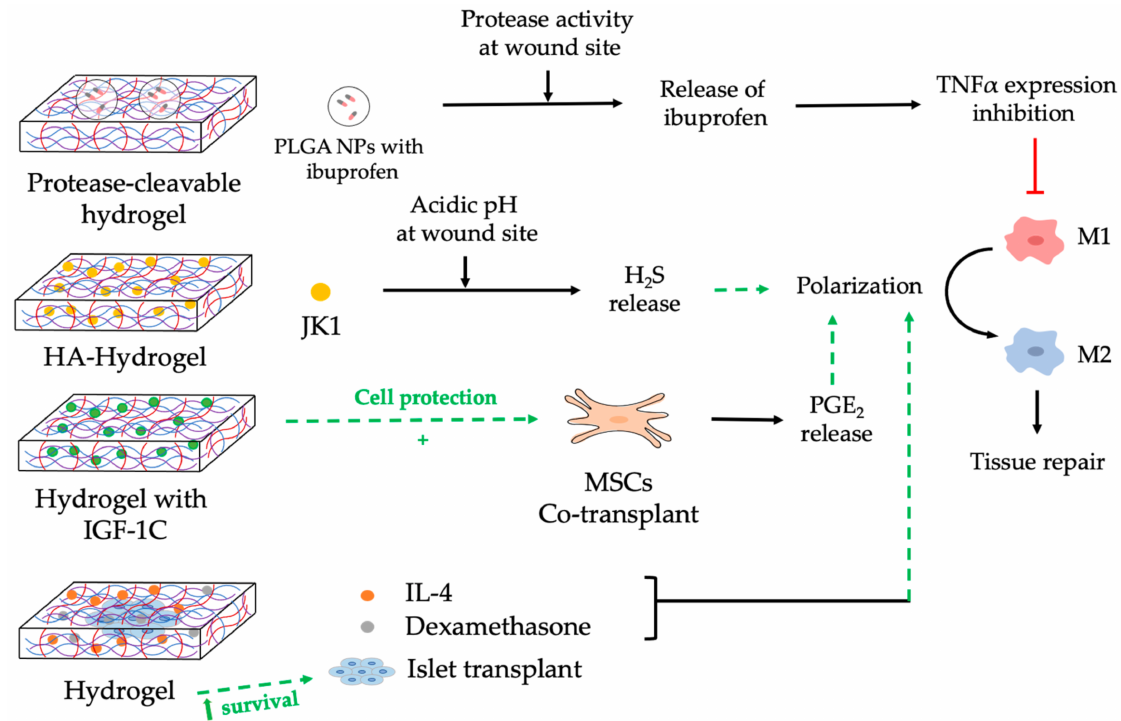
Figure 7. Nanocomposite hydrogels to modulate macrophages. This figure illustrates four examples of hydrogels designed to induce macrophages polarization for tissue repair. The first hydrogel encapsulates NPs with anti-inflammatory drugs that are released upon exposure to protease activity. The second hydrogel contains a donor (JK1) that can be triggered in a pH-dependent manner to release pro-regenerative molecules (H 2 S). The third hydrogel is loaded with molecules (IGF-1C) that promote co-transplanted MSCs survival, which modulates macrophage function. The fourth hydrogel encapsulates transplanted cells (islet transplant) and pro-regenerative molecules (IL-4, Dexamethasone). PLGA: poly (lactic-co-glycolic acid); NPs: nanoparticles; TNF α : tumor necrotic factor alpha; HA: hyaluronan; H 2 S: hydrogen sulphide; Insulin-like growth factor 1 (IGF-1C); MSC: mesenchymal stem cells; PGE2: prostaglandin E2; IL: